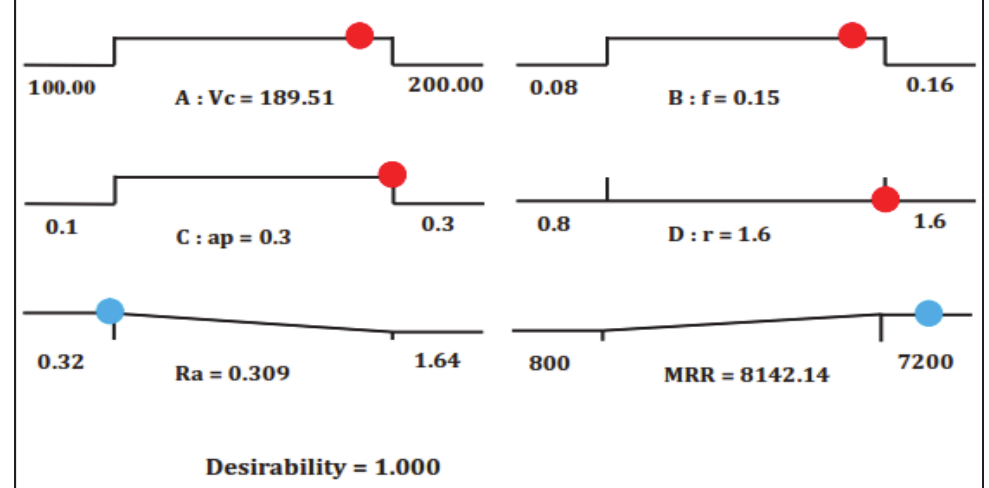
Fig. 13. Solution ramps of multi-objective optimization